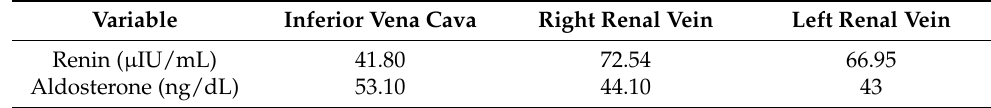
Table 2. Bilateral renal vein sampling. Table 1. Postural stimulation tests.